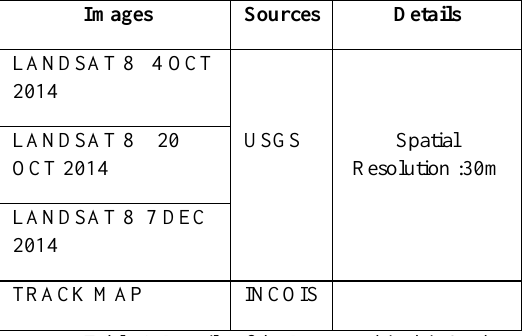
Figure 3. Flow chart of the methodology